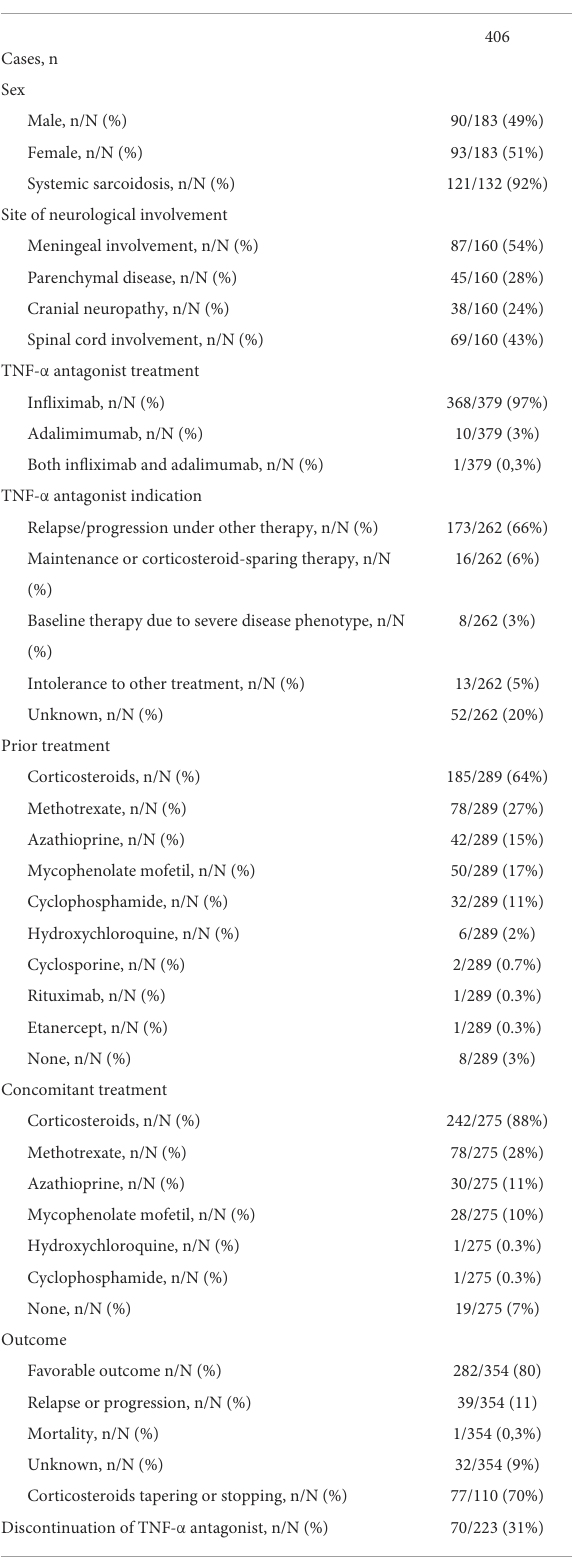
TABLE 9 Combined disease characteristics, management, and outcomes of neurosarcoidosis cases treated with the anti-TNF- α antagonist from our cohort ( n = 2) and the literature ( n =